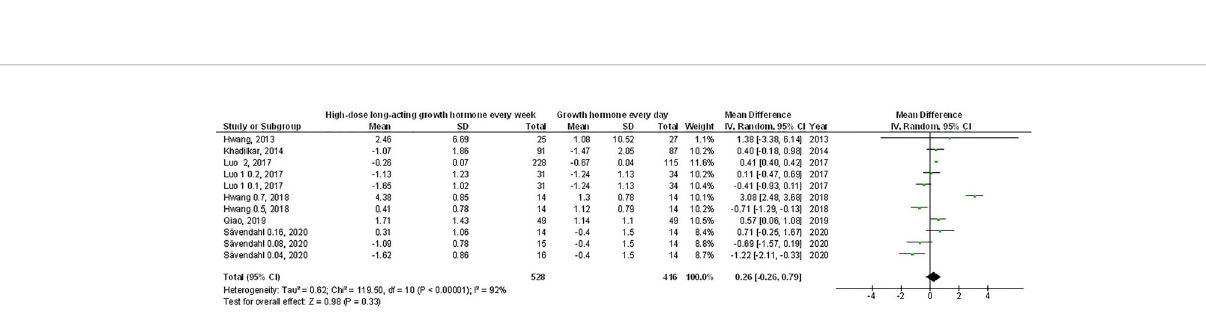
FIGURE 4 | Forest plot of the change in height standard deviation scores bone age in long-acting growth hormone replacement therapy compared to daily growth hormone.